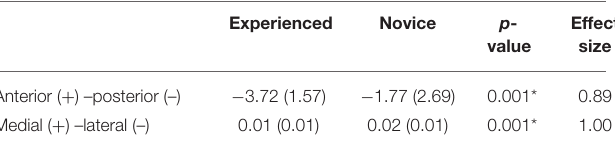
TABLE 4 | COM-ankle inclination angles at retire position